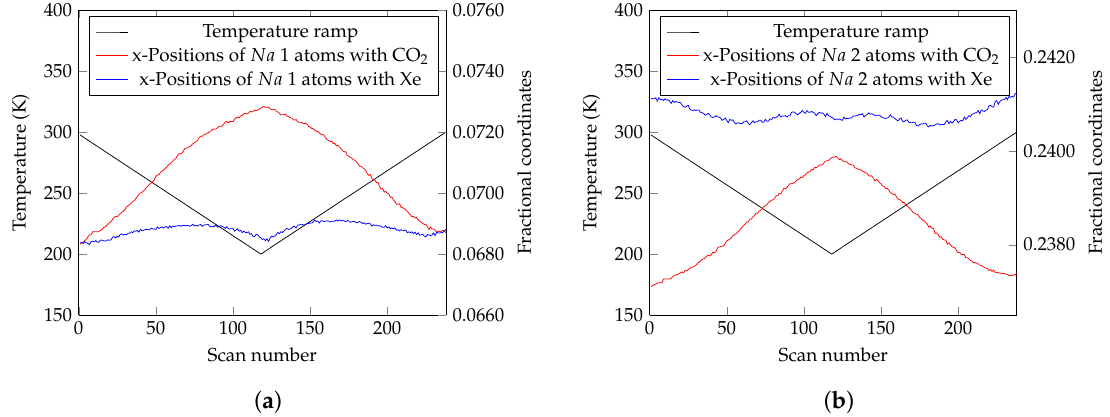
Figure 3. Position variations of Na atoms. ( a ) x positions of Na1 (x,x,x) with CO 2 (mean error: 0.0002) and Xe (mean error: 0.0003). ( b ) x positions of Na2 (x,x,x) with CO 2 (mean error: 0.0002) and Xe (mean error: 0.0003).